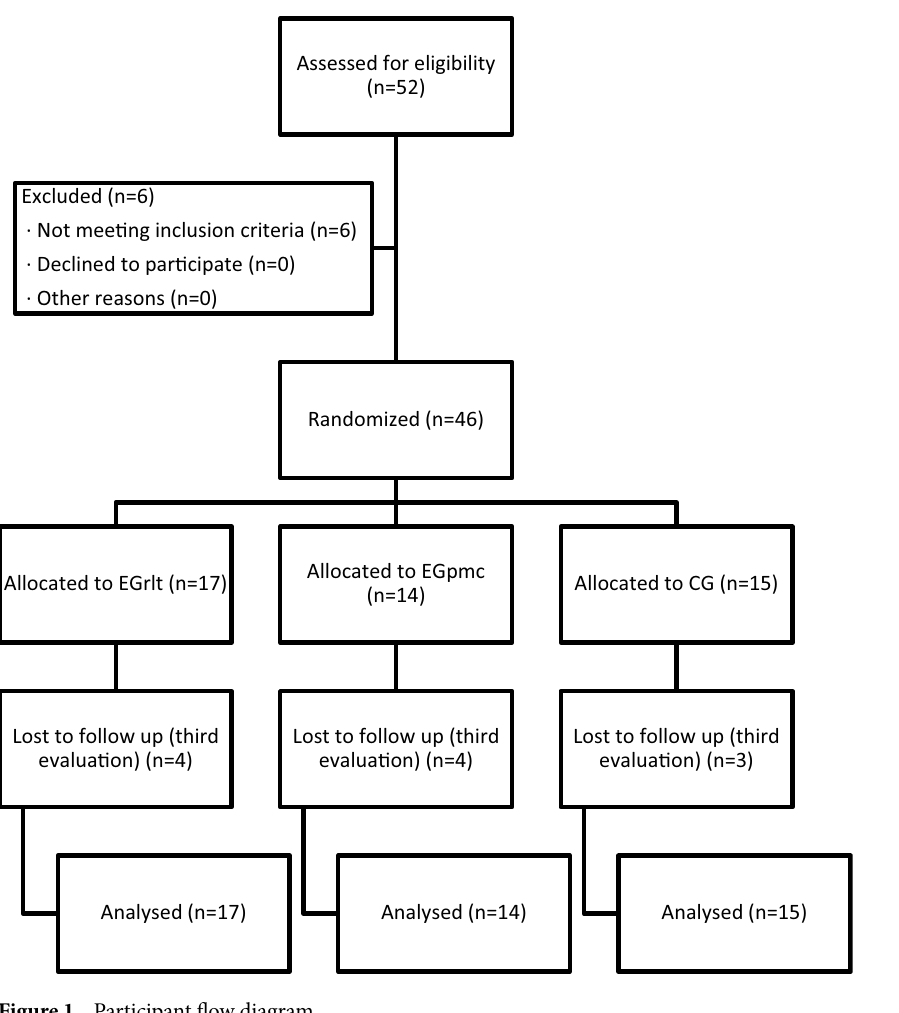
Figure 1. Participant flow